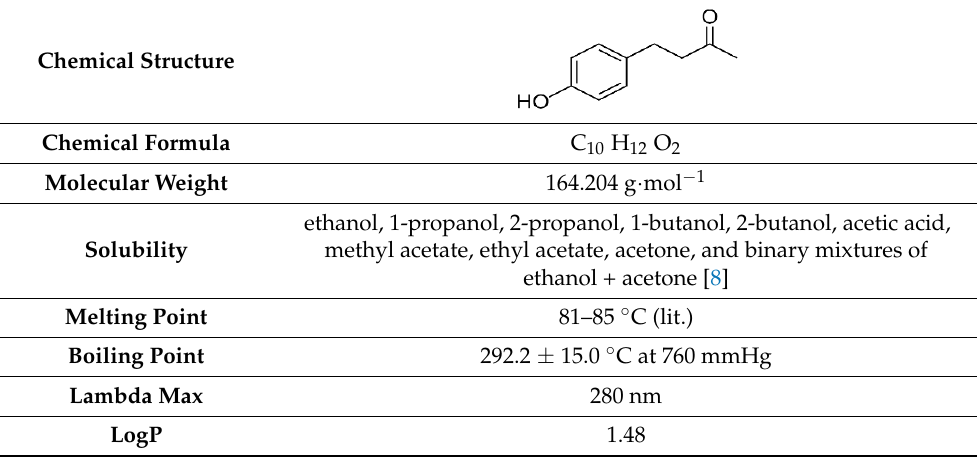
Table 1. Physiochemical properties of raspberry ketone (RK).